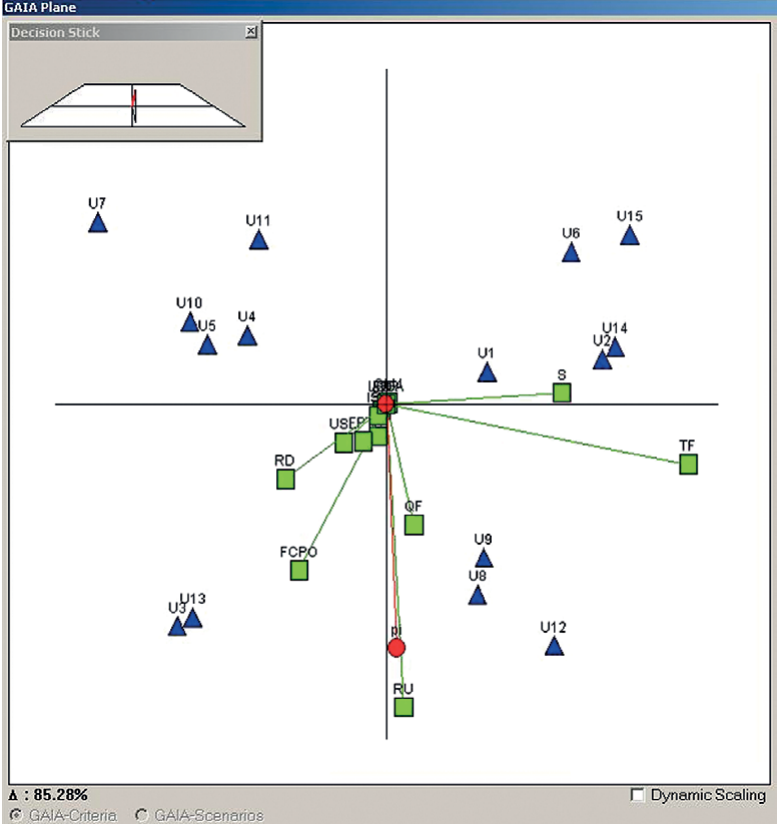
Fig. 5. GAIA plane for university